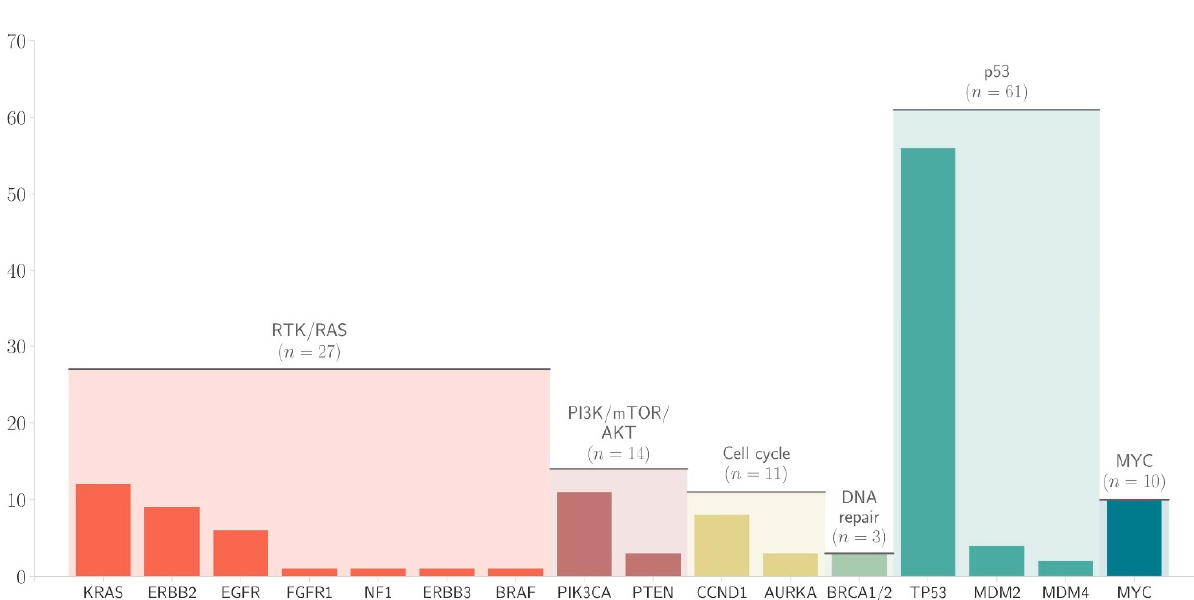
Table 3. The ESMO classification of the alterations of various genes and their therapeutic relevance by ESCAT level. Table adapted from [14].